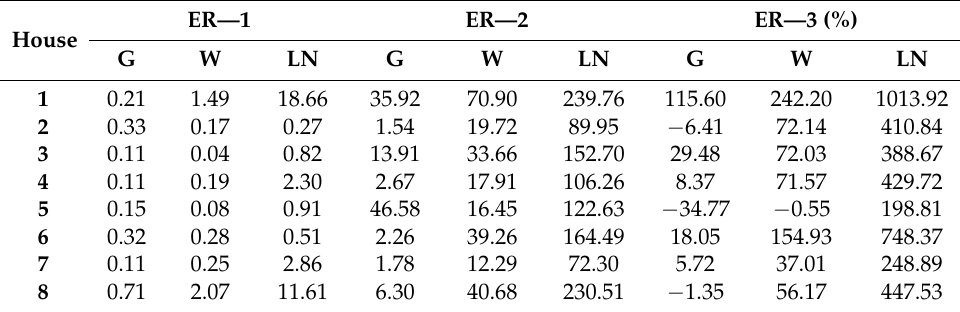
Table A4. Fitting performance of the three distributions on the entire nonzero records of each household at 15-minute (upper part) and hourly (lower part) scale. “W” stands for Weibull distribution, “G” for Gamma distribution, and “LN” for Lognormal